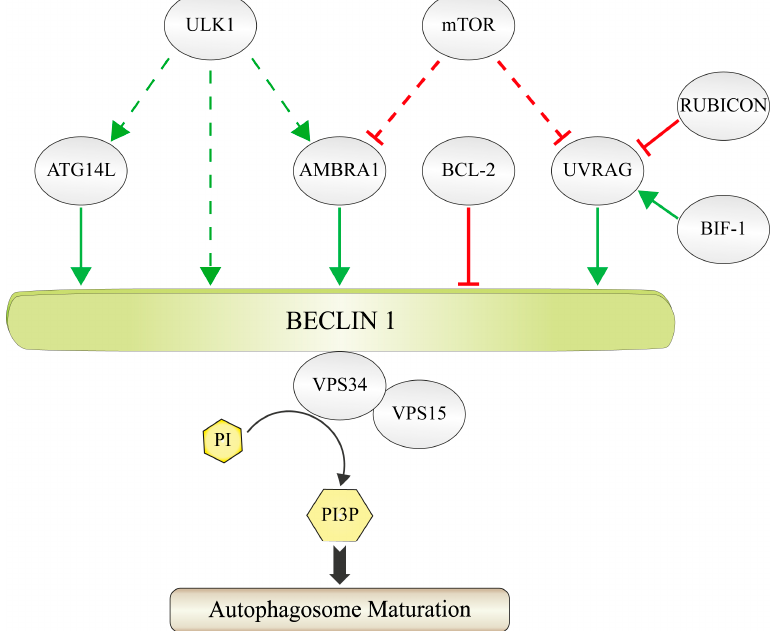
Figure 1. Composition of the PI3K-III complex. The figure shows the most important constituents of the PI3K-III complex in mammals. VPS34 is the catalytic subunit, which uses phosphatidylinositol (PI) as substrate in order to generate phosphatidylinositol 3-phosphate (PI3P). VPS34 forms the core complex together with the putative protein kinase VPS15 and the adaptor protein BECLIN 1. Additional regulatory proteins can bind to the core complex via BECLIN 1 in a context-dependent manner and therefore may not all be present at the same time. ATG14L, AMBRA 1 and UVRAG support the activity of VPS34 and therefore autophagosome maturation (green arrows). The contribution of UVRAG is supported by BIF-1 and inhibited by RUBICON (red lines). BCL-2 is an inhibitor of BECLIN 1. AMBRA 1 and UVRAG are inactivated via the phosphorylation by the protein kinase mTOR (red dashed lines). AMBRA 1, ATG14L and BECLIN 1 are activated via the phosphorylation by the protein kinase ULK1 (green dashed arrows).